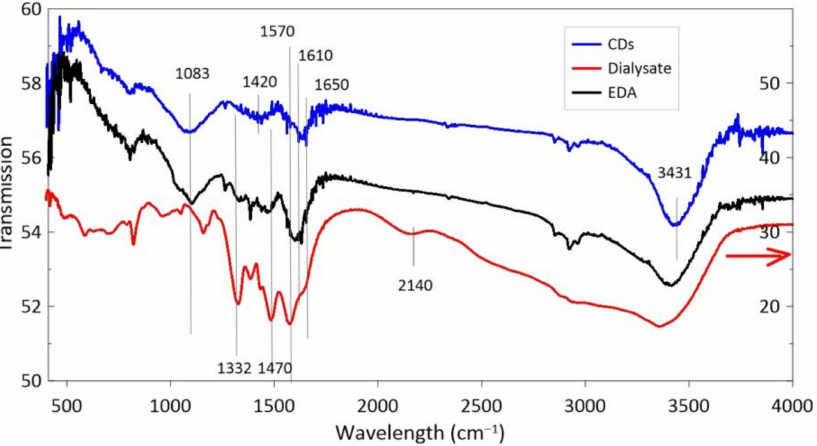
Figure 5. FTIR spectra of CDs synthesized in ethylenediamine (EDA). The red arrow indicates the scale for the